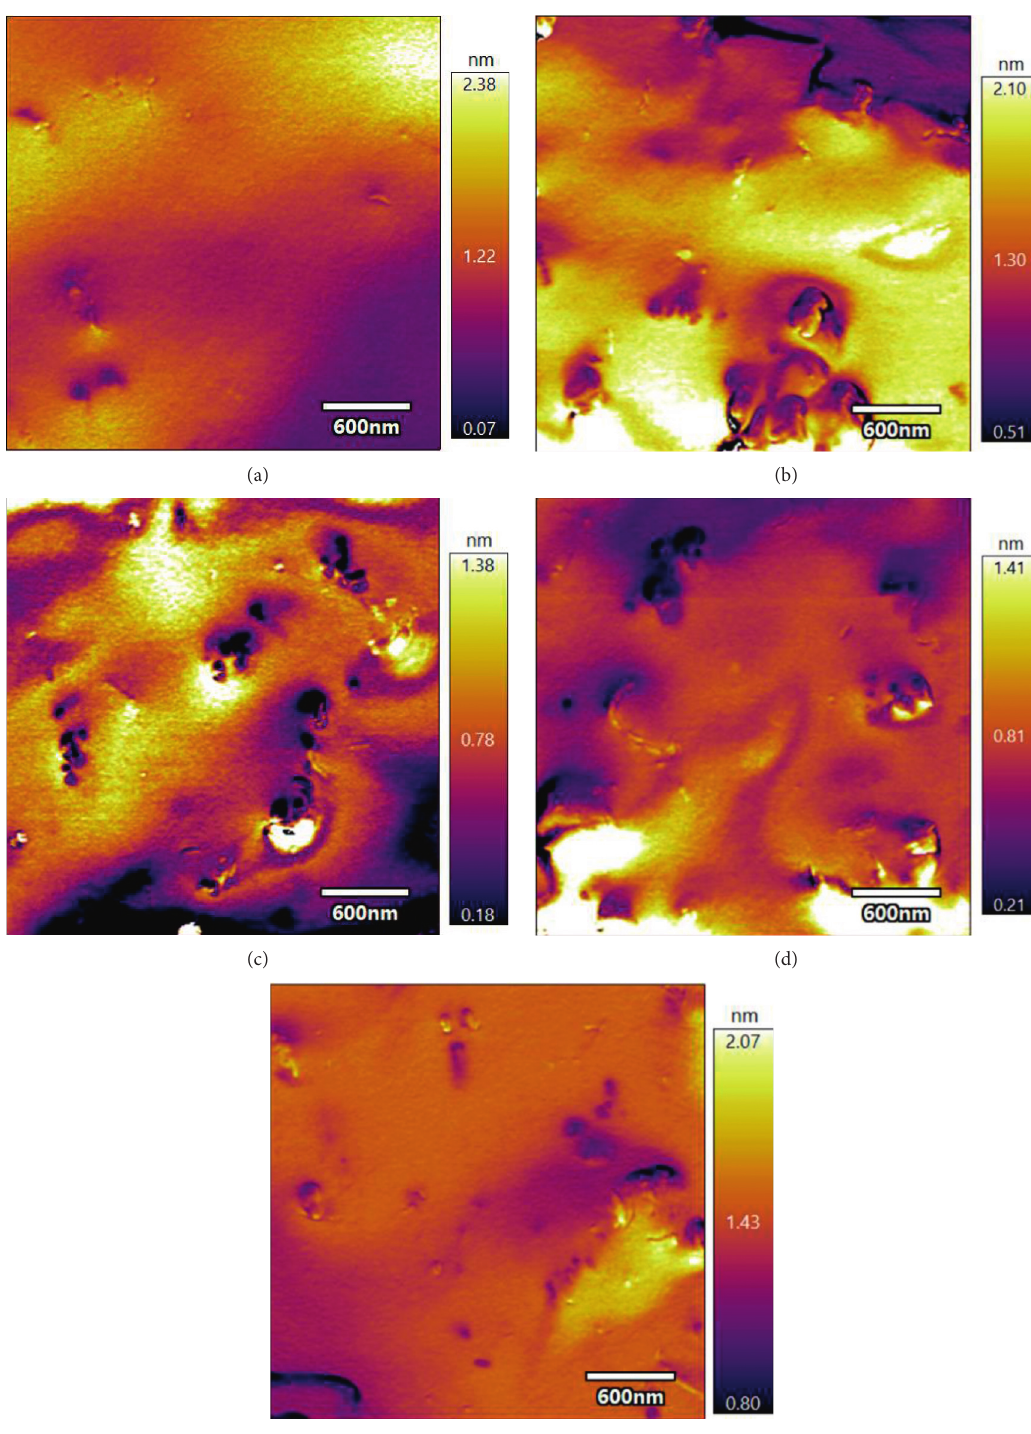
Figure 6: Indentation depth image of (a) C-10, (b) C-15, (c) C-20, (d) C-25, and (e)